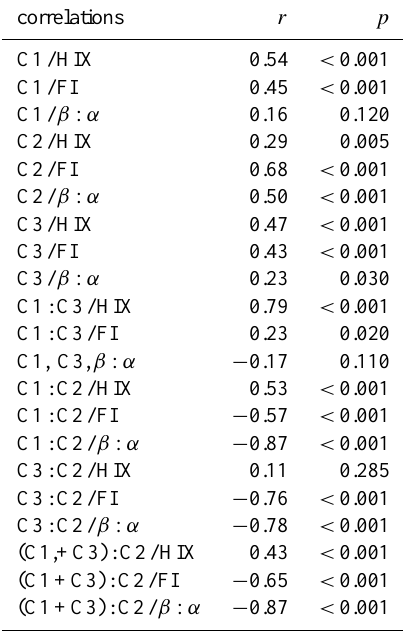
Table 3. Spearman’s rank correlation between PARAFAC compo- nents, component ratios and fluorescence indices ∗